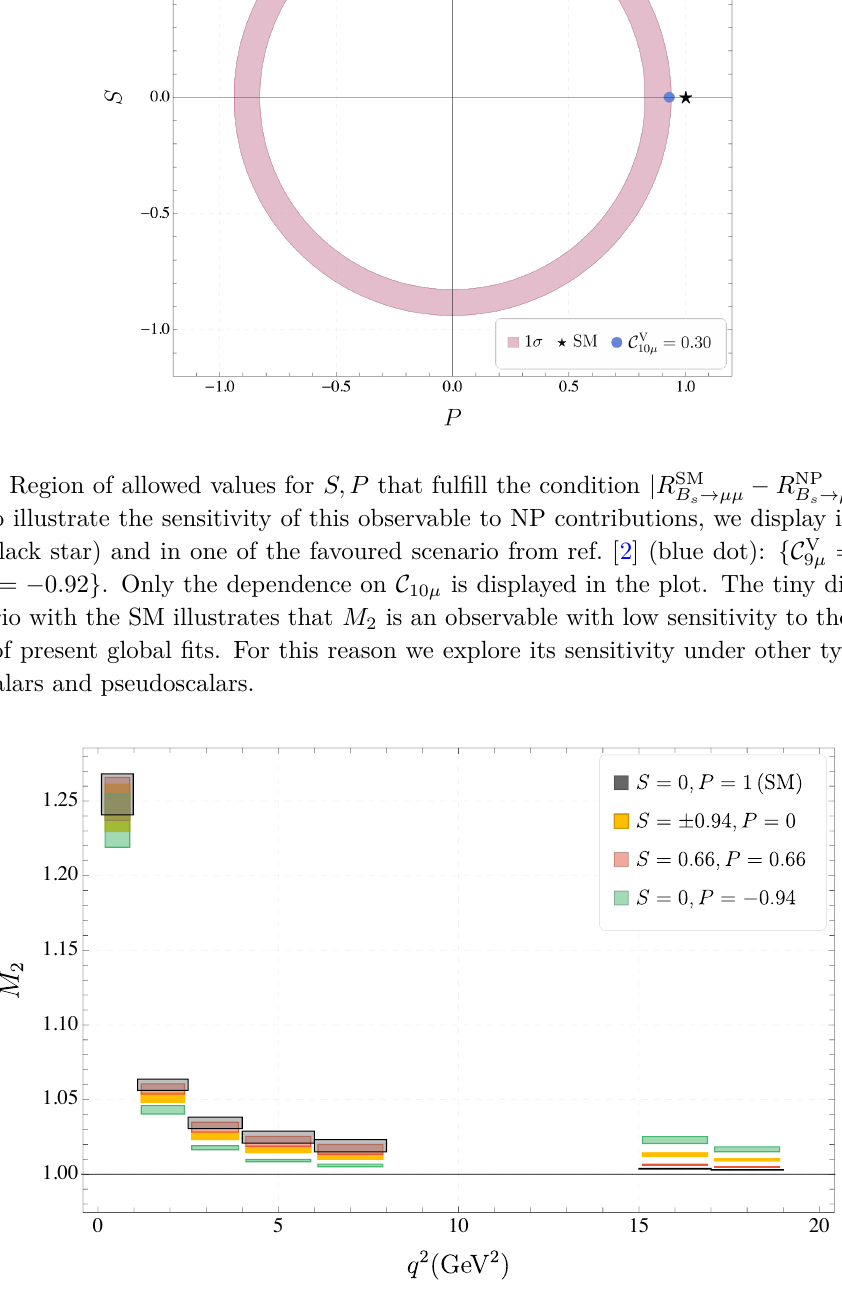
Figure 2 . Binned theoretical predictions for M 2 in the SM and in selected NP scenarios including pseudoscalar and scalar